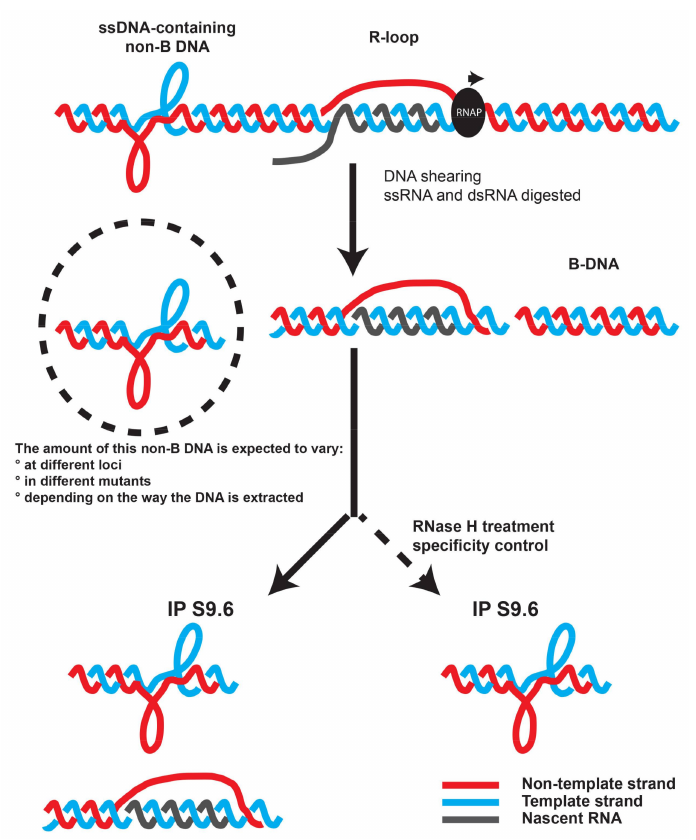
Figure 2. The S9.6 antibody is likely to recognize also ssDNA-containing non-B DNA forms that do not correspond to R-loops